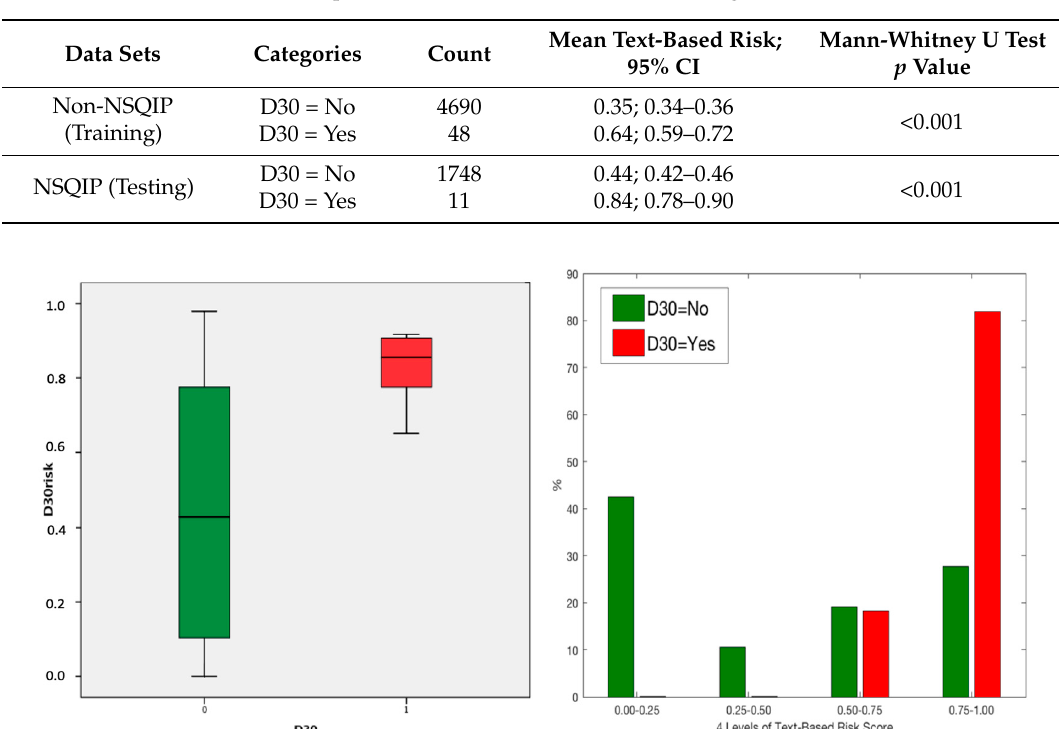
Table 1. Comparison of text-based risk scores for categories of D30.